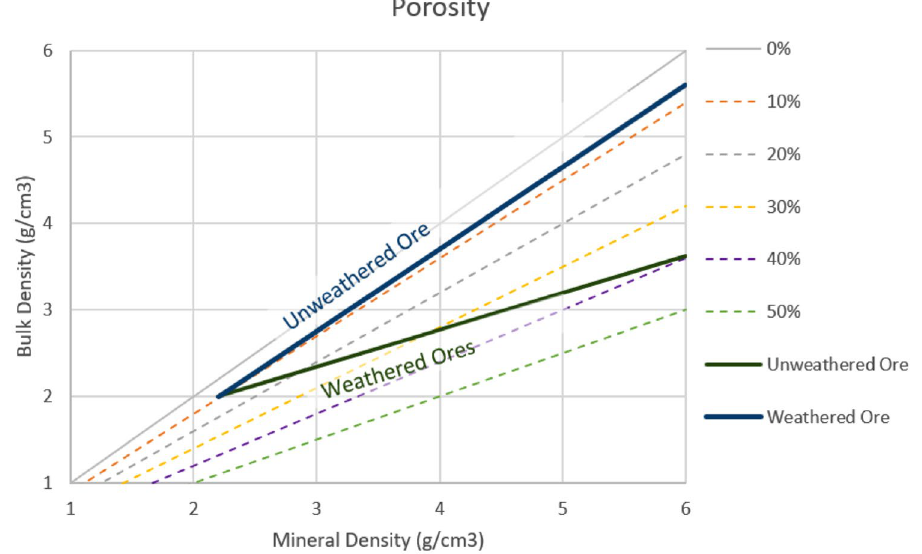
Fig. 5 Relationship among mineral density, bulk density and porosity. The latter is expressed as linear regressions in the range of 0% porosity (thin straight line) to 50% porosity (dashed lines), and for friable (weathered) and compact (unweathered) ore samples from the Quadrilátero Ferrífero; adapted from Motta et al.